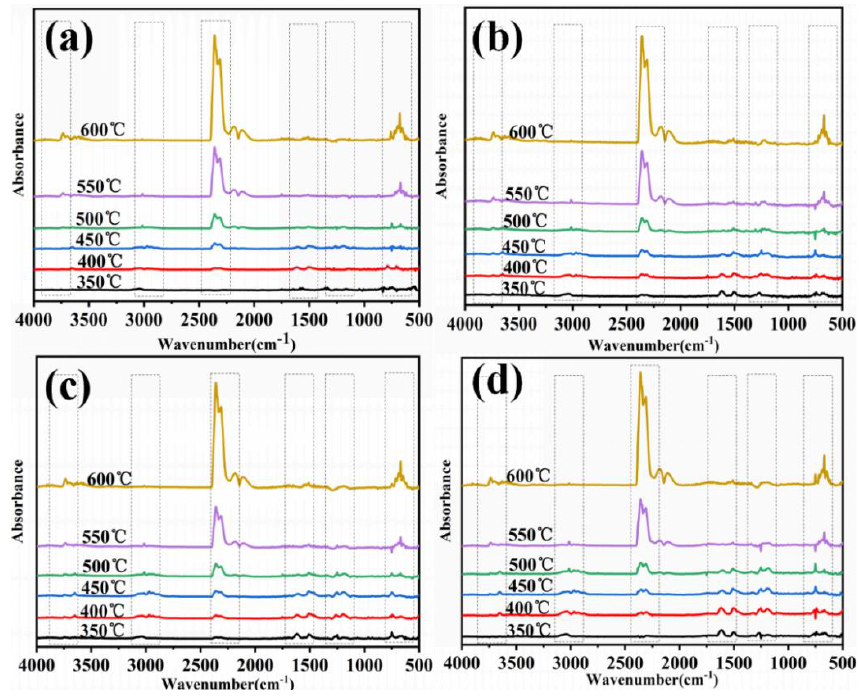
Figure 11. FTIR spectra of ( a ) PBa, ( b ) PBa/PD−fu−1%, ( c ) PBa/PD−fu−3% and ( d ) PBa/PD−fu−5% at various temperatures.